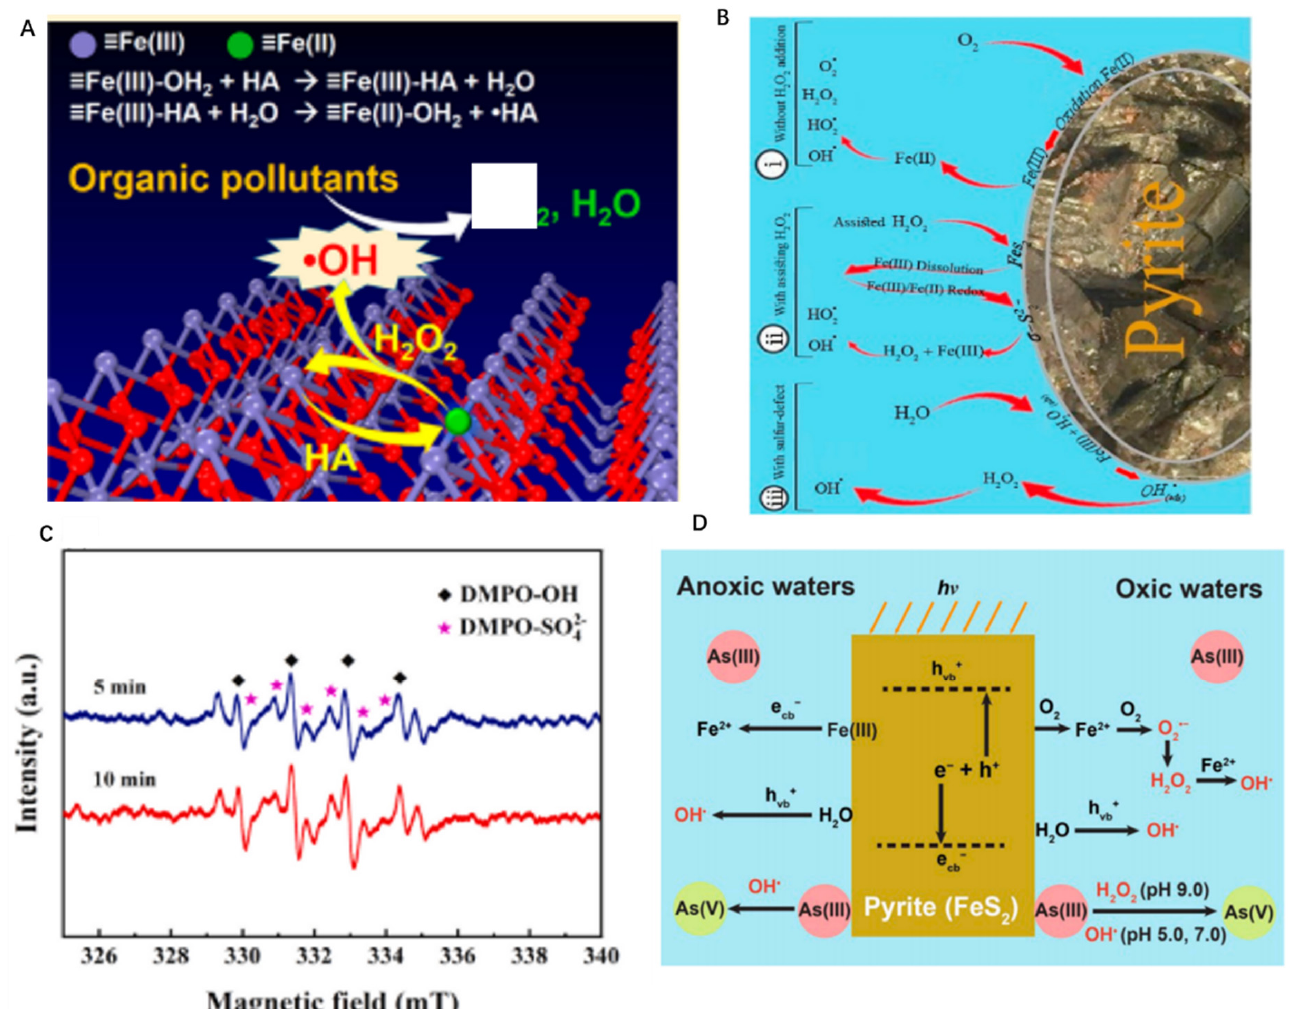
Figure 4. ( A ) Schematic diagram of degradation of organic matter by hydrogen peroxide activated by goethite, copyright 2017 American Chemical Society. ( B ) Schematic diagram of pyrite activation of Fenton reaction, copyright 2020 Elsevier Ltd. ( C ) Schematic diagram of free radical generation from persulfate system activated by pyrite, copyright 2020 Elsevier B.V. ( D ) The oxidation of As(III) by pyrite. Copyright 2021 Elsevier Ltd.